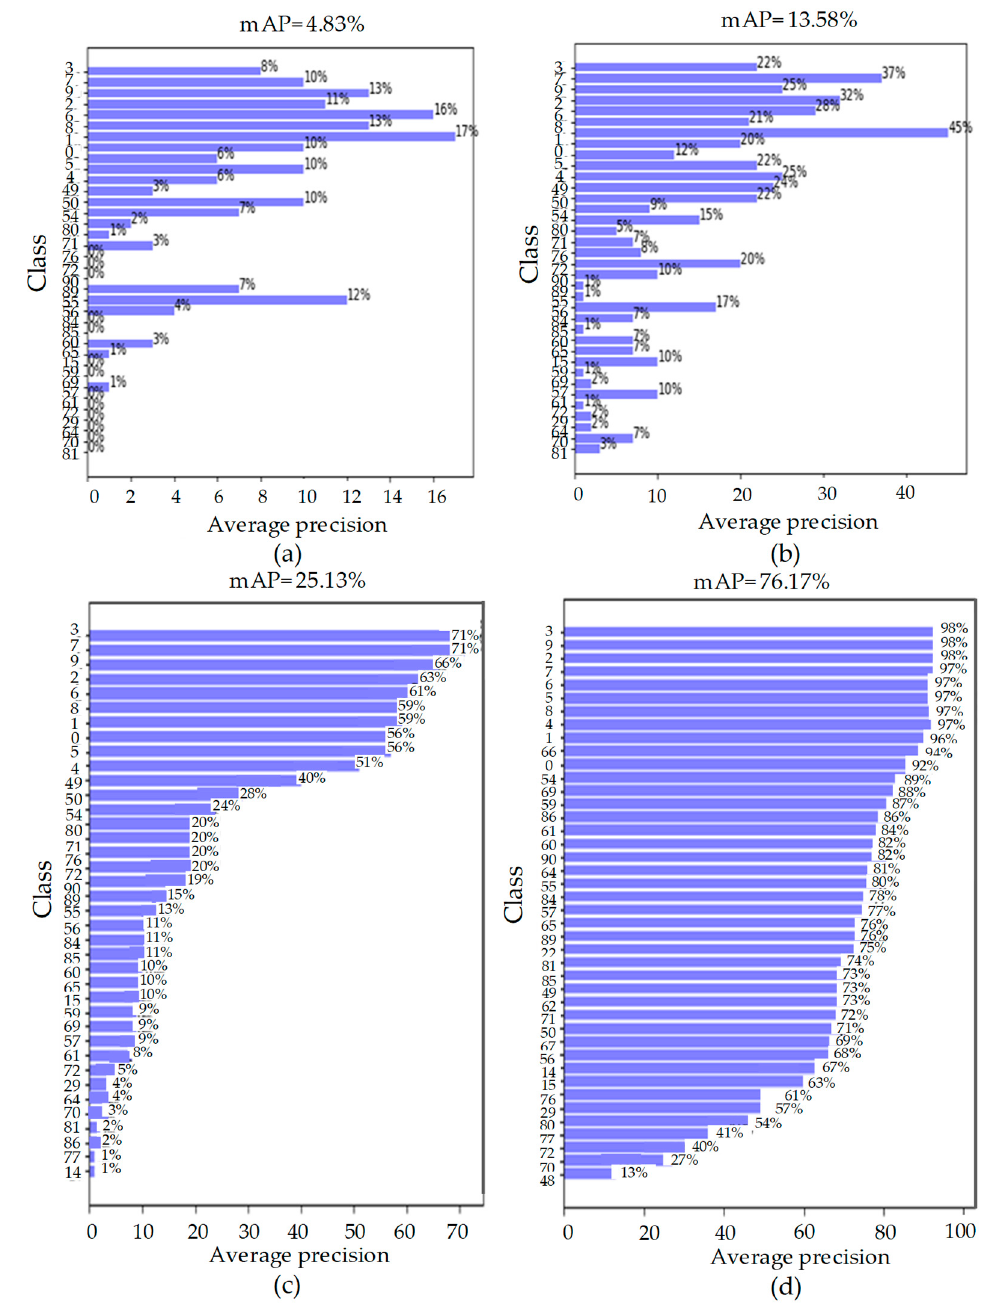
Figure 17. mAP comparison results. ( a ), ( b ), ( c ), ( d ) represent the mAP results on bicubic results (×4), DBPN results (×4), proposed SR results (×4), and HR images, respectively.